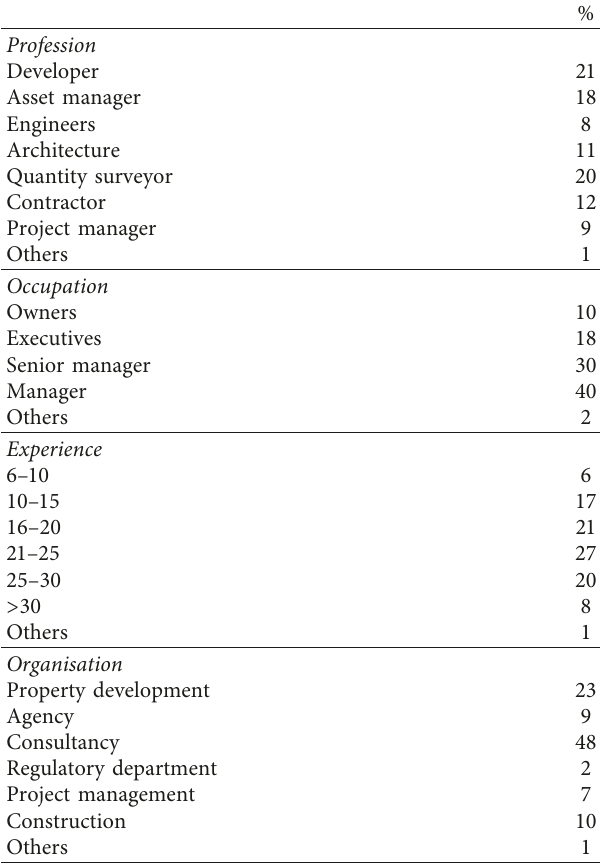
Table 2: Background information of the